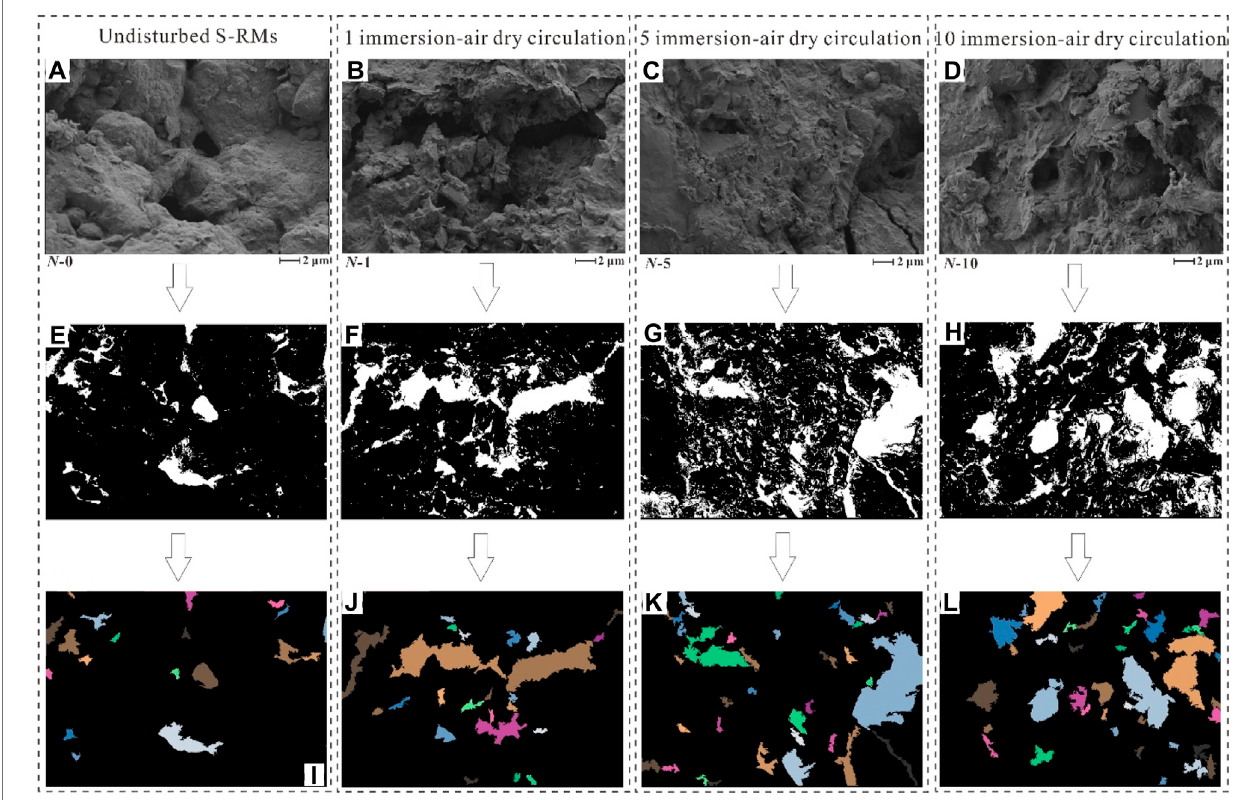
FIGURE 12 | Pore recognition process: (A – D) are SEM original pictures; (E – H) are the results of binarization; (I – L) are the results of pore identi fi cation.